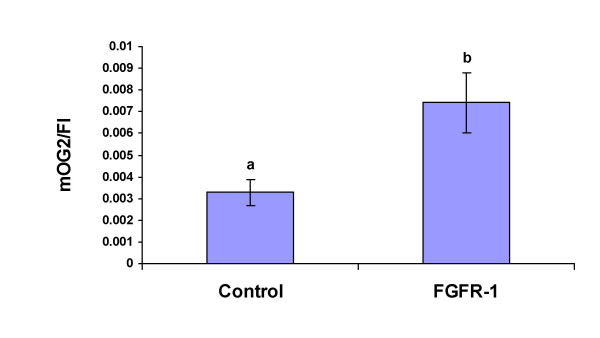
Downstream detection of activated FGF signaling. Activity of mouse osteocalcin gene 2 promoter (mOG2)-luciferase reporter gene in gastrocnemius and soleus muscles of mice transfected with either control (control) or FGFR1 expression plasmid DNA (FGFR1). Data are expressed as luciferase dependent light units normalized to renilla luciferase dependent light units (mOG2/Fl). Means (±SEM) bearing different letters differ significantly (P < 0.01).